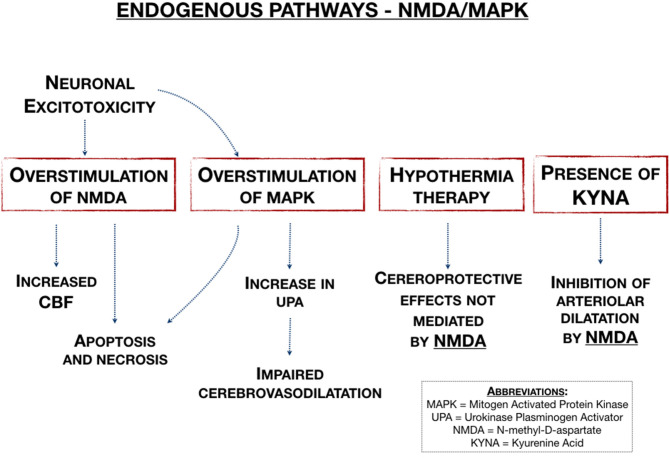
Endogenous pathways associated with NMAD and MAPK (32–35, 38, 40).